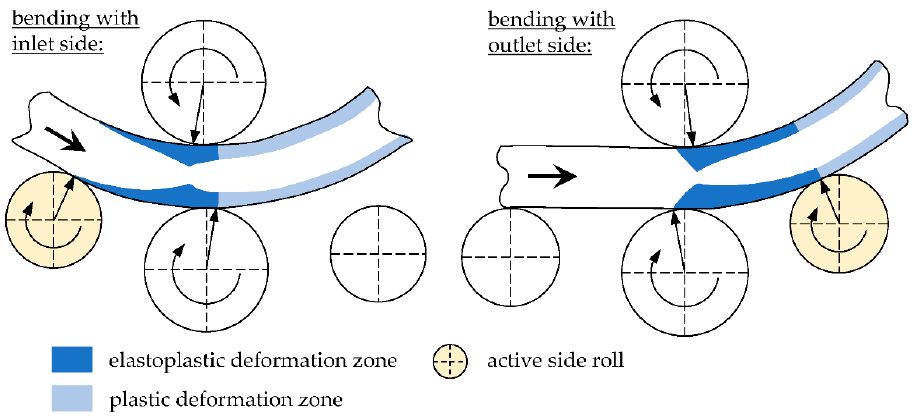
Figure 3. Different roll bending variants and propagation of the deformation zone.